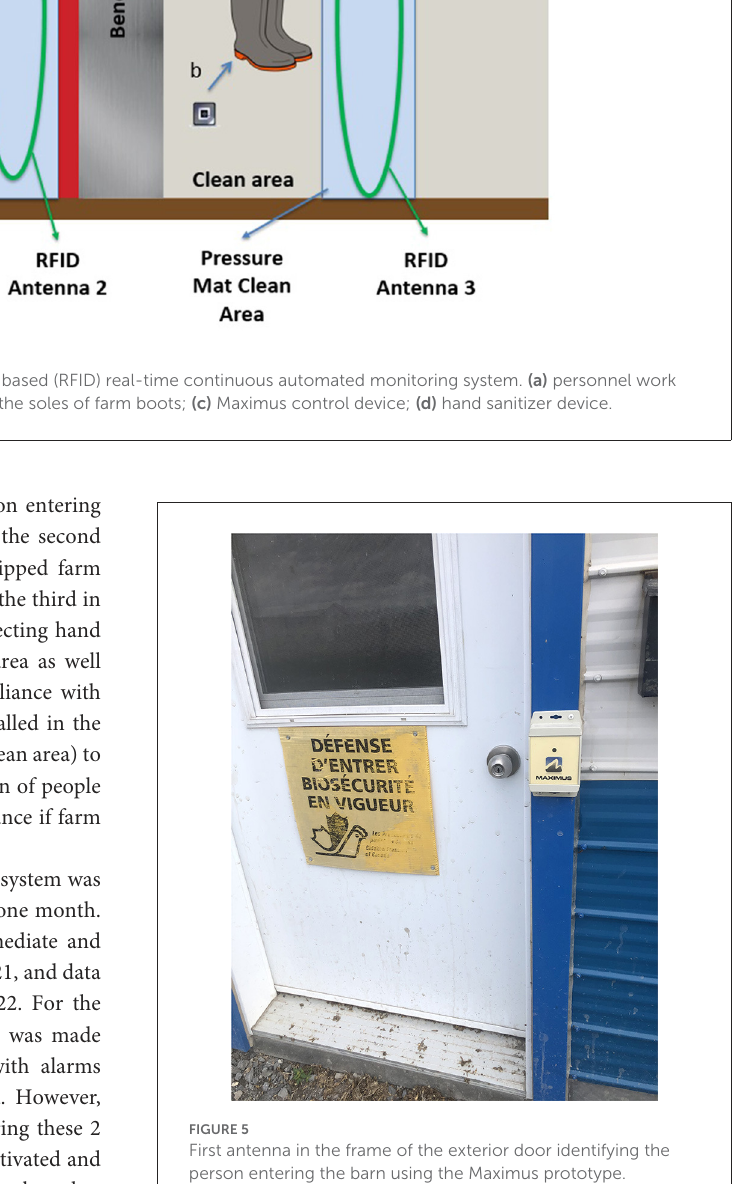
during weekends. Visits in the morning accounted for 57% of all visits (60 in the morning, 45 in the afternoon). Employees did on average 15 visits each during the study period according to their access cards read by antenna 1 (Figures 4, 5). The